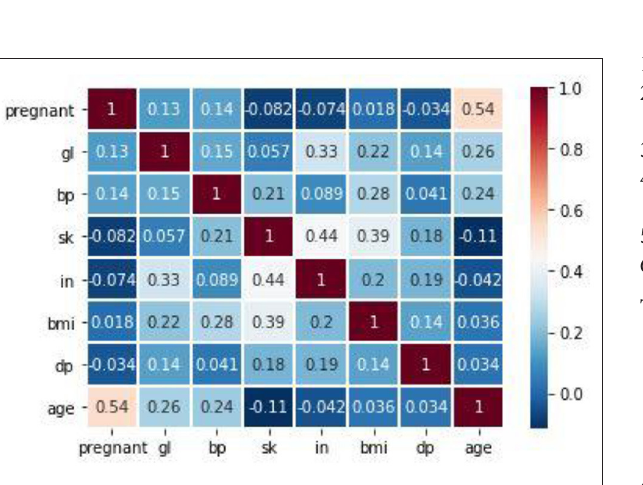
FIGURE 7 | Pearson correlation coefficient result of Pima input attribute